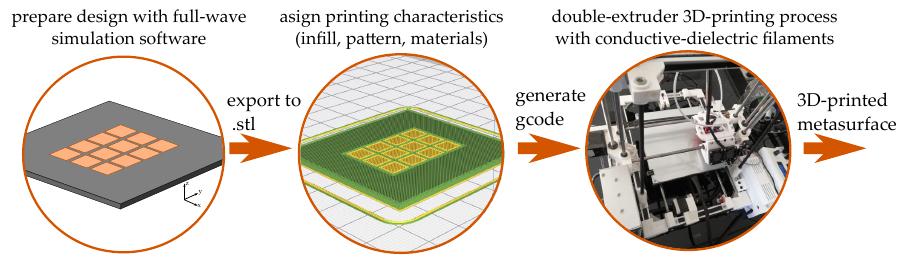
Figure 12. 3D-printing process: from design to